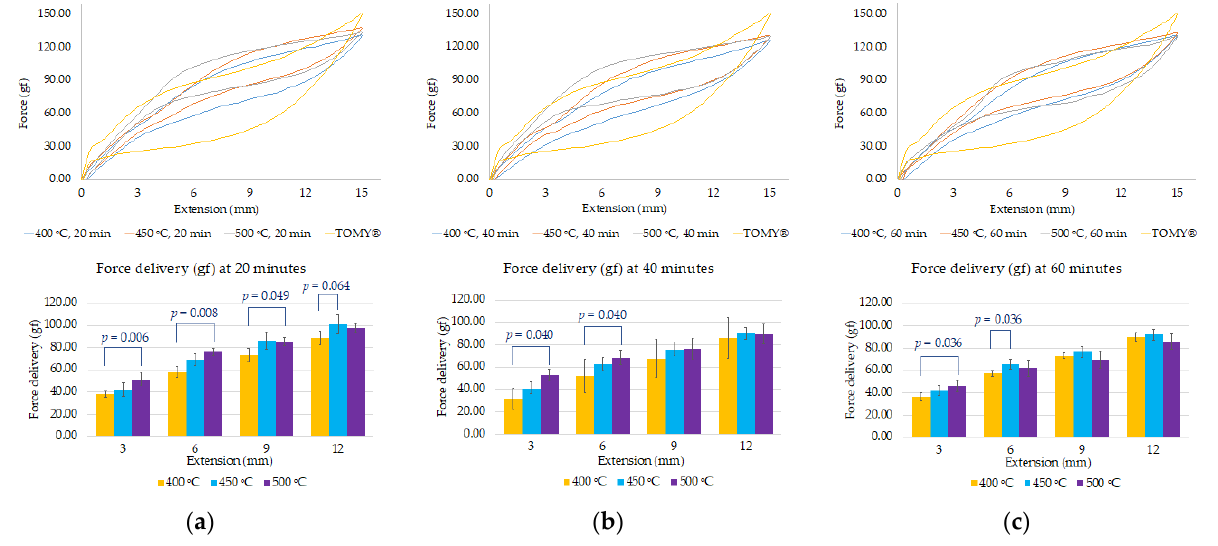
Figure 4. Superimpose of load-extension curves of custom-made closed coil springs under different heat treatment conditions with commercial NiTi closed coil springs (TOMY ® ): ( a ) at a constant tem- perature (400 °C) with various durations; ( b ) at a constant temperature (450 °C) with various dura- tions; ( c ) temperature (500 °C) with various durations.